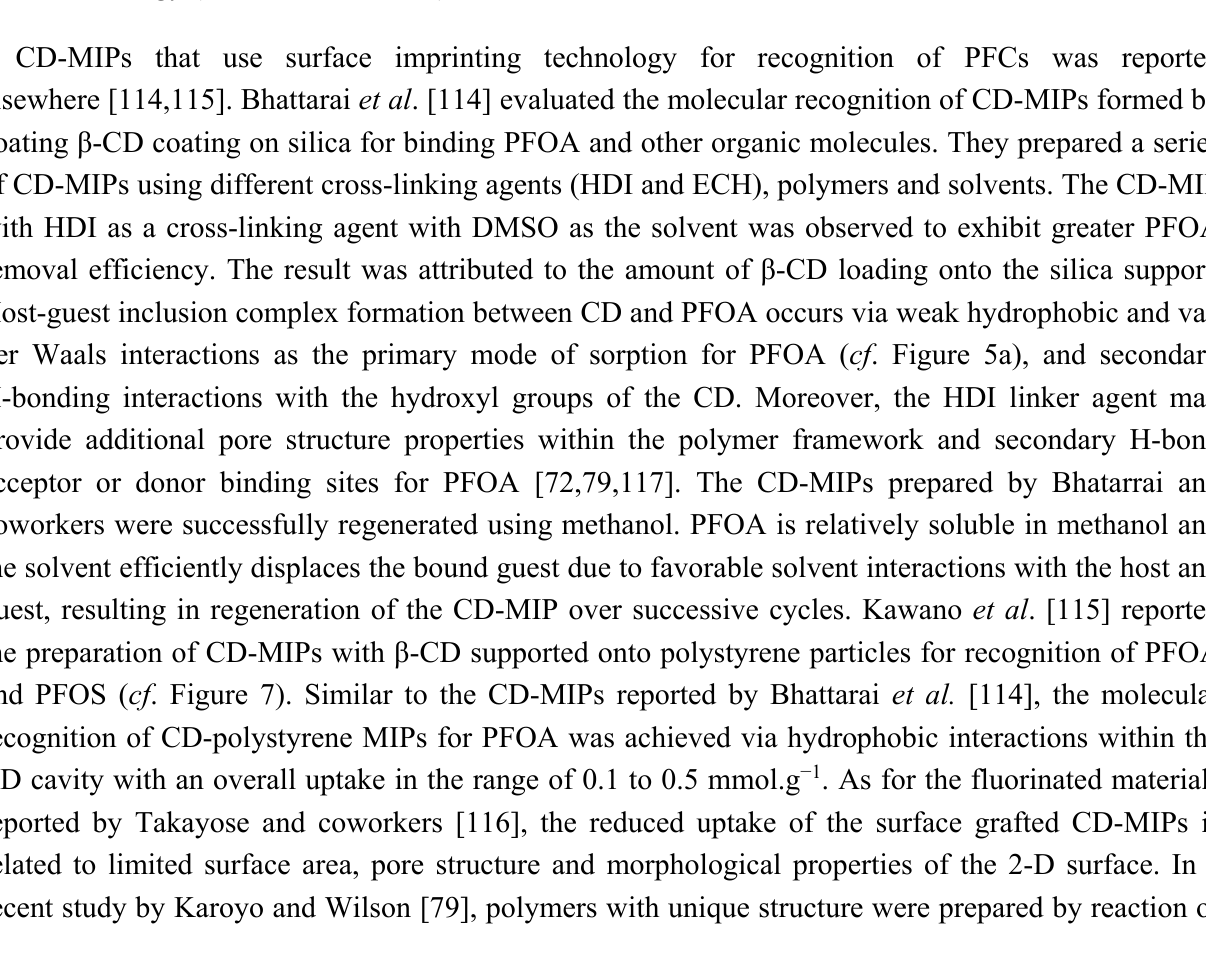
Figure 7. Schematic showing mechanism of CD-MIPs preparation using surface imprinting technology (redrawn from